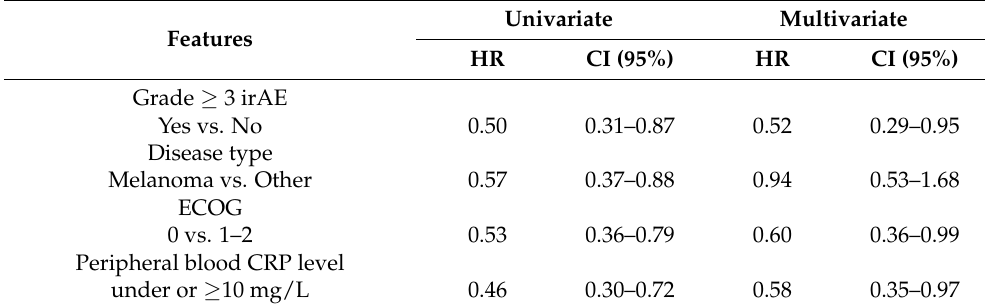
Table 3. Univariate and multivariate analysis for progression-free survival according to the presence of grade ≥ 3 irAE or grade ≥ 3 endocrinological or dermatological